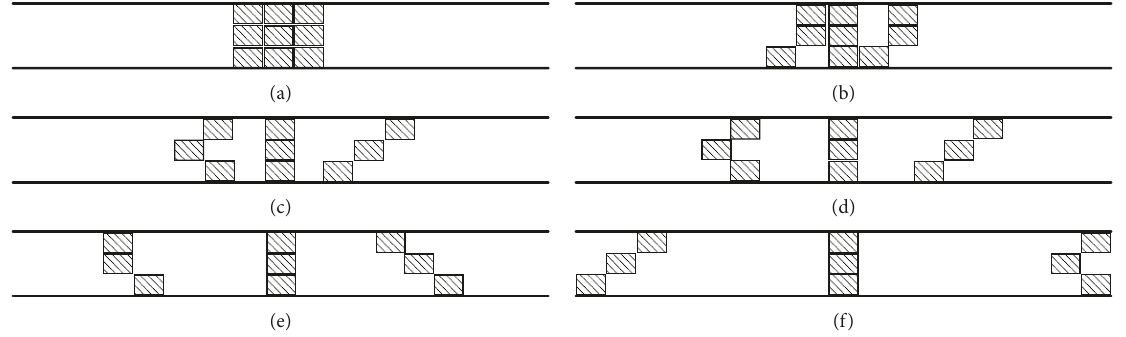
� 0.047 l , f � 0; (b) u � 0.056 l , f 2 : (a) u 2